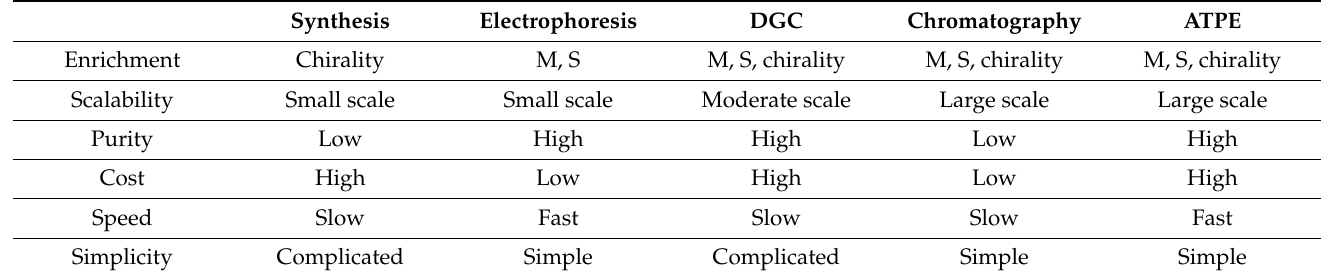
Table 1. Main methods of separation of CNTs with targeted type of sorting and obtained